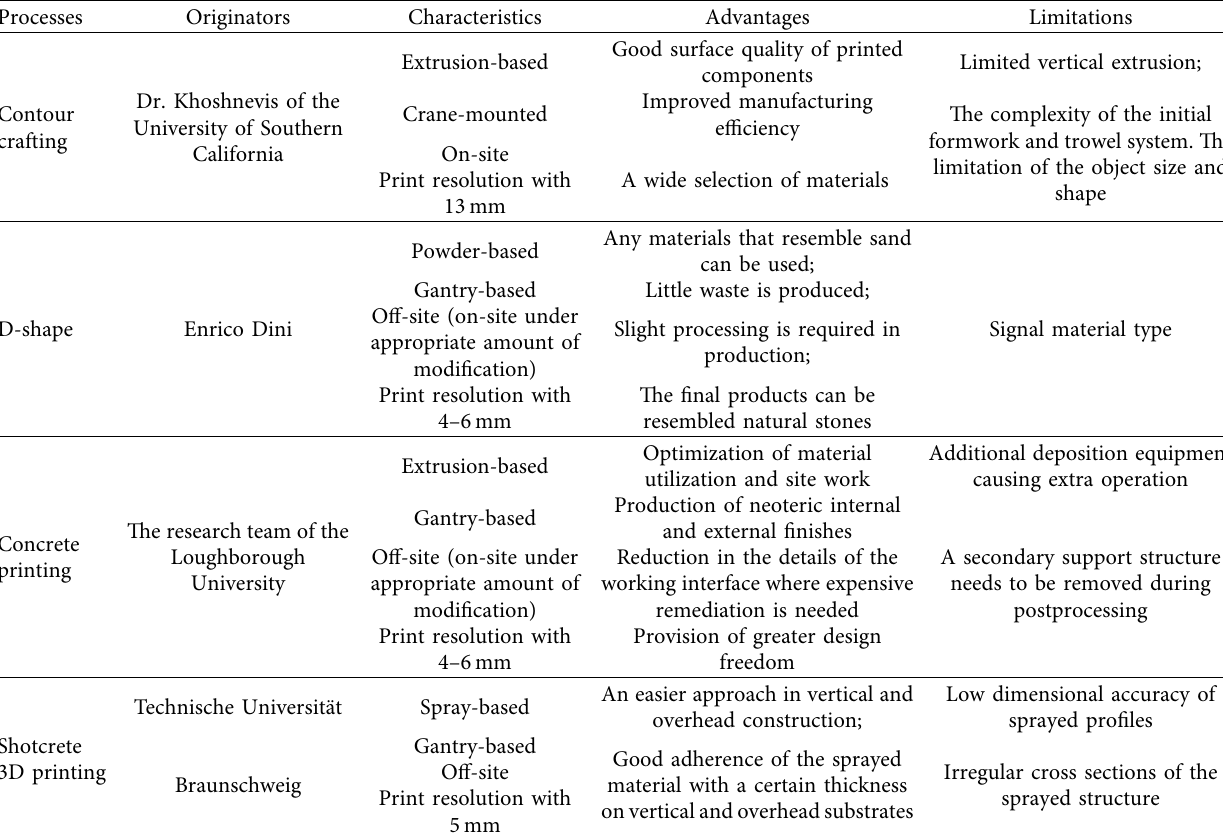
Table 4: Current state of the art of 3DP